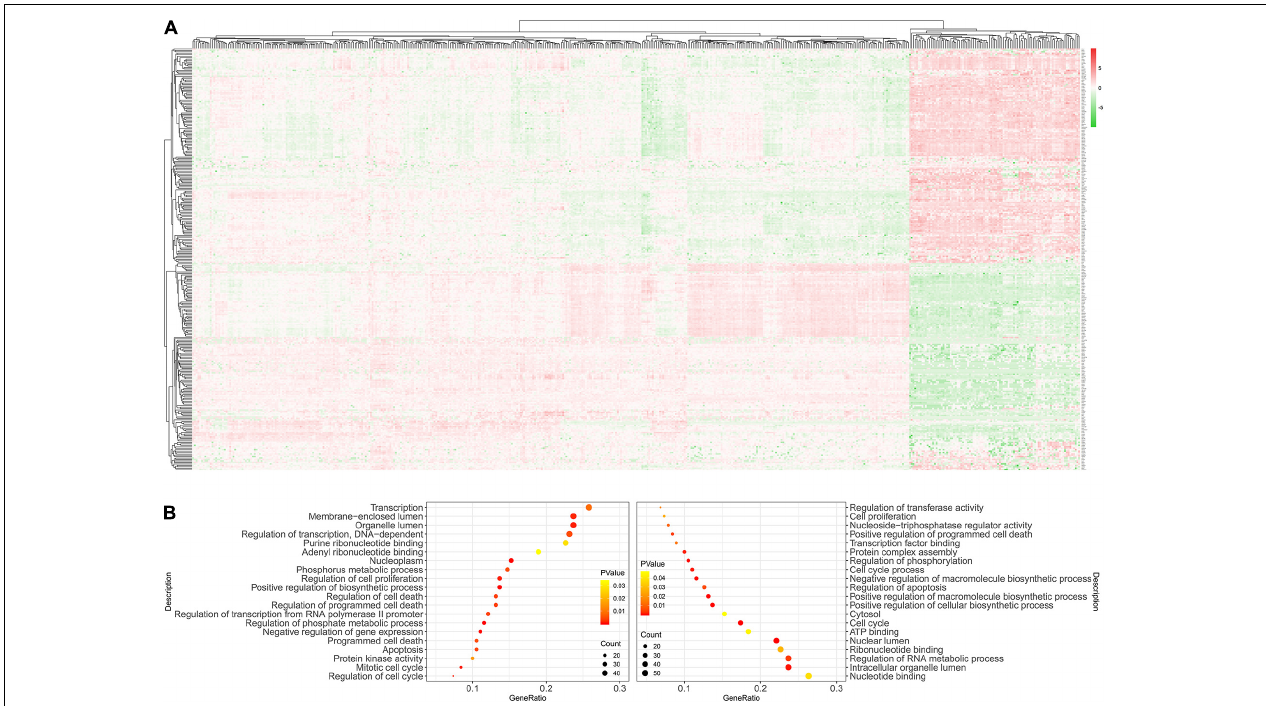
FIGURE 5 | GO enrichment analysis of DEmRNAs in the ceRNA network. (A) Heatmaps showing differences in the expression patterns of all DEmRNAs in the ceRNA network between ALL bone marrow samples and normal samples. Red stands for upregulation and green stands for downregulation. (B) The top 40 GO enrichment analysis results including biological process, cellular component, and molecular function. DEmRNAs: Differentially expressed mRNAs.